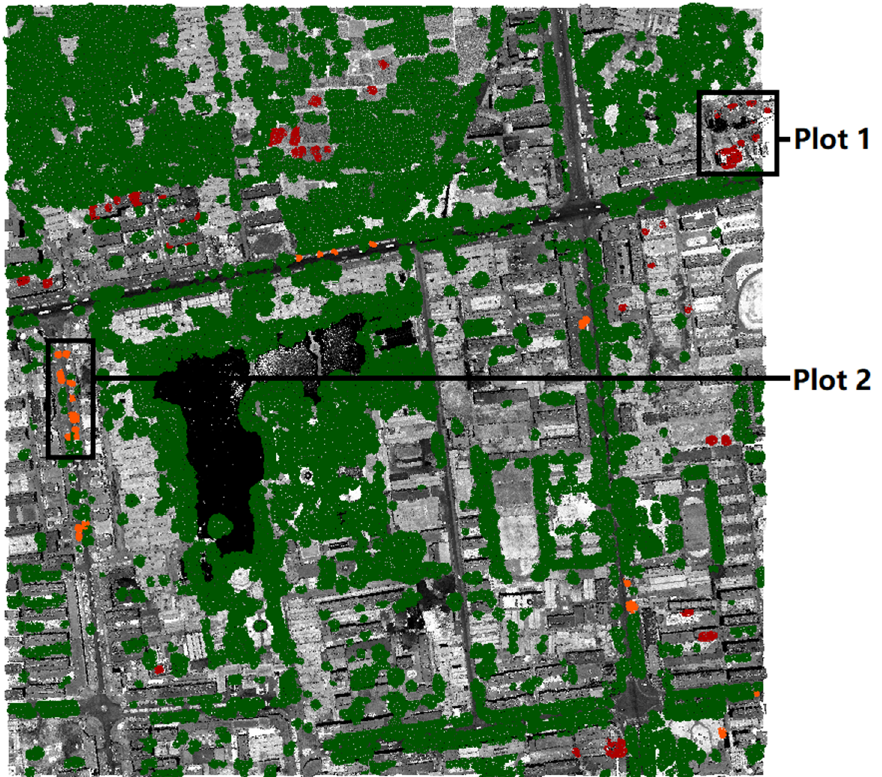
Figure 7. Tree point extraction results of the airborne LiDAR data. Most trees in the study area are well extracted (green points). Street shrubs with small, flat canopies are more likely missed (orange points). Large balconies and facades of tall buildings are the main components of mis-extractions (red points). Only two representative plots were selected for type I error and type II error, respectively. Table 2. Confusion matrix for airborne LiDAR data extraction